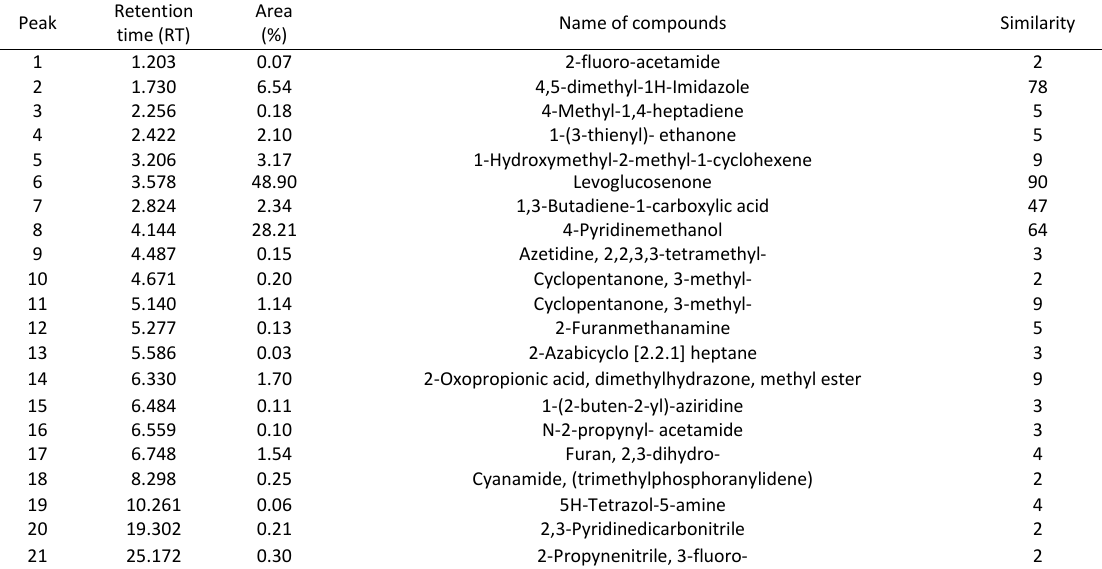
Table 6: GC-MS analysis of K. alvarezii hot water extract